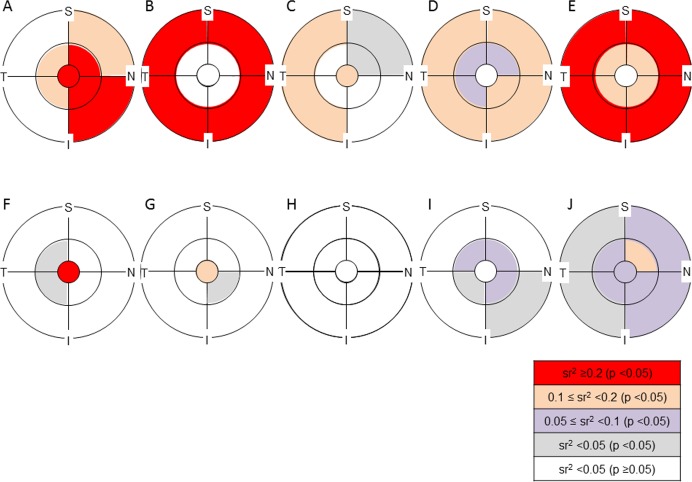
Semipartial correlation of axial length with the thickness of retinal layers in each analytical area with or without magnification correction.The significance of the semipartial correlation coefficient (sr) and magnitude of the sr squared (sr2) are color coded in each analytical area. S = superior, N = nasal, I = inferior, T = temporal. A, F: retinal nerve fiber layer (RNFL), B, G: ganglion cell layer plus inner plexiform layer (GCLIPL), C, H: ganglion cell complex (GCC), D, I: total retina, E, J: outer retina. A—E: ‘magnification-uncorrected’ analytical area, F—J: ‘magnification-corrected’ analytical area. A large sr2 (≥0.2) was observed in RNFL, GCLIPL and outer retina in ‘magnification-uncorrected’ analytical areas. After magnification correction, most of the sr in the inner retinal layers, especially in GCC, became insignificant. In contrast, the sr were still significant in most of the analytical areas of the outer and total retina after magnification correction.